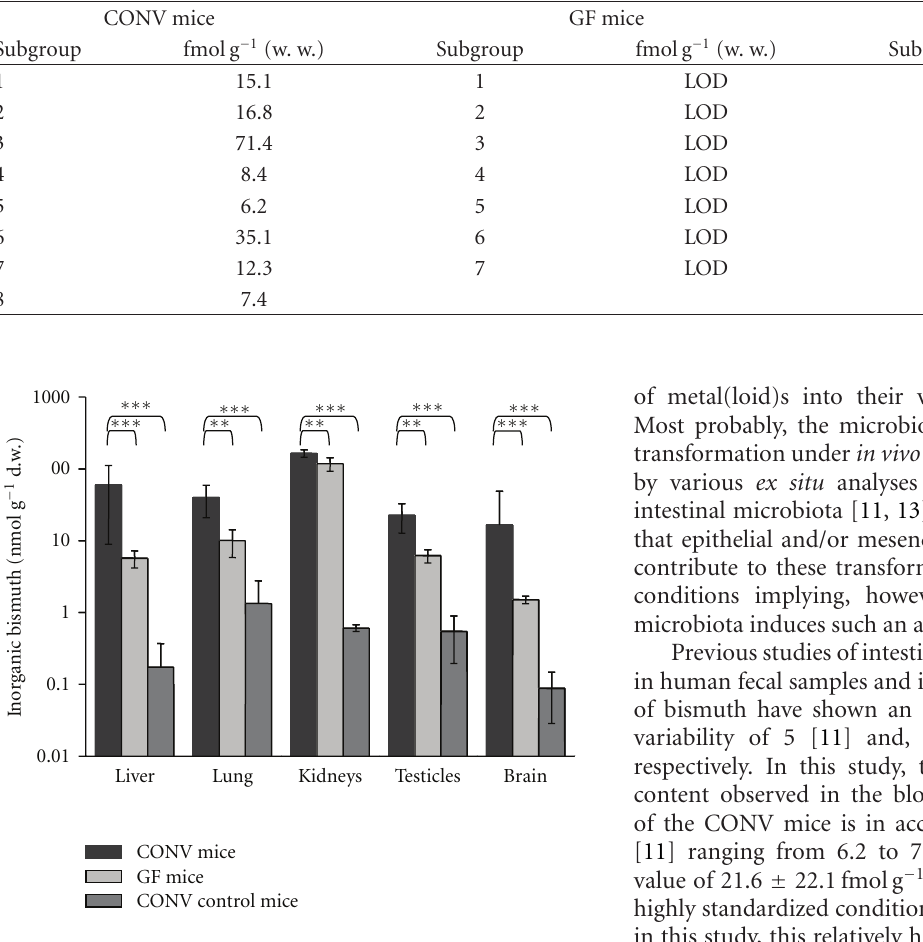
Figure 1: Bismuth content (means ± SD (nmolg − 1 d. w.)) of organ tissues of CONV mice and GF mice fed with CBS containing chow as well as that of the CONV control mice fed with a standard diet. (Significance levels: ∗∗∗ P < 0 . 001, ∗∗ P < 0 .